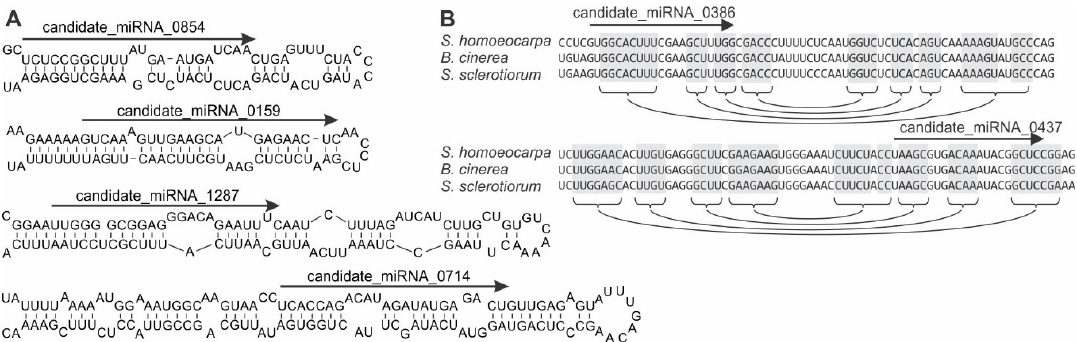
Figure. 3. Examples of sRNA producing loci in the S . sclerotiorum genome (A) capable of folding into Figure 3. Examples of sRNA producing loci in the S . sclerotiorum genome ( A ) capable of folding into structures similar to pre ‐ microRNA and (B) conserved in the genomes of other members of the family structures similar to pre-microRNA and ( B ) conserved in the genomes of other members of the family Sclerotiniaceae. Arrows indicate the positions of mature microRNA ‐ like sequences. Connected Sclerotiniaceae. Arrows indicate the positions of mature microRNA-like sequences. Connected shaded shaded boxes indicate regions of conserved base pairing in predicted stem ‐ and ‐ loop structures. boxes indicate regions of conserved base pairing in predicted stem-and-loop